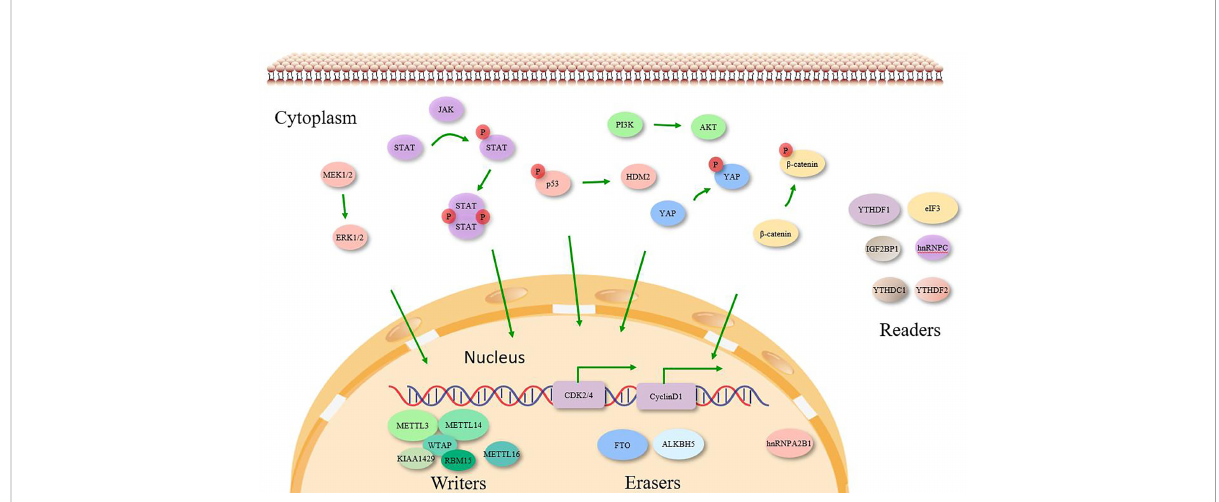
FIGURE 2 Molecular targets of m6A enzymes in various signaling pathways. m6A ‘ Writers ’ , ‘ Erasers ’ and ‘ Readers ’ play signi fi cant role in cancer by targeting speci fi c RNA transcripts of cell signaling molecules causing activation/inactivation of various intracellular signaling pathways, which are indicated by the colors corresponding to the